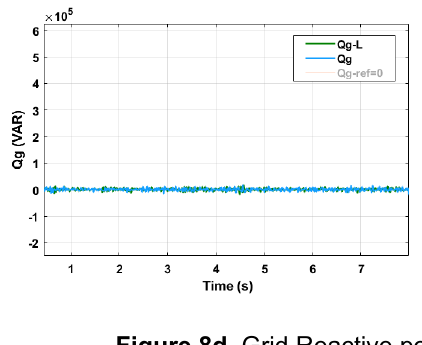
Figure 8c. DC link voltage Figure 8d. Grid Reactive power